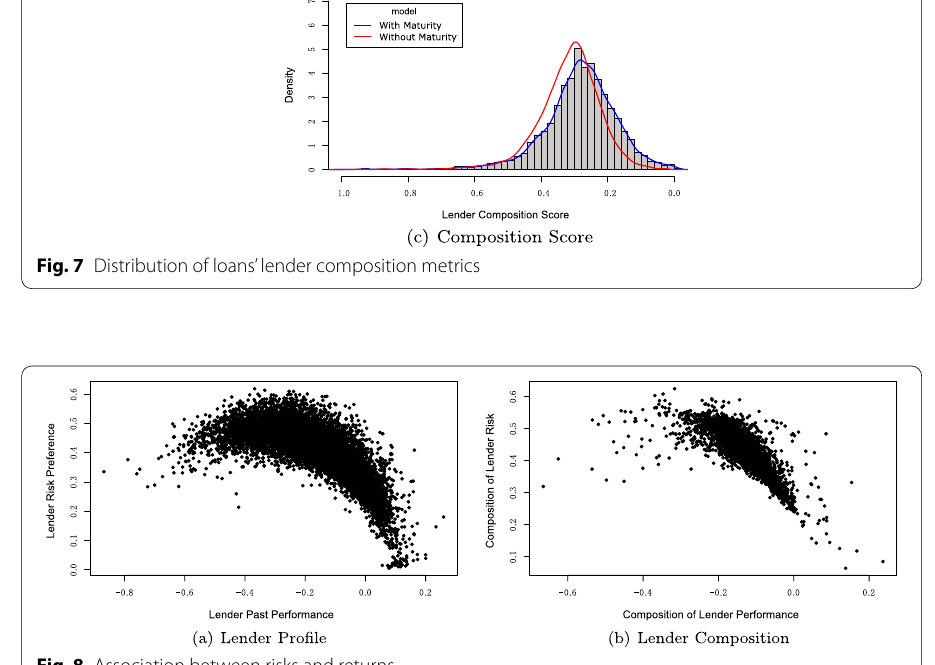
Fig. 8 Association between risks and